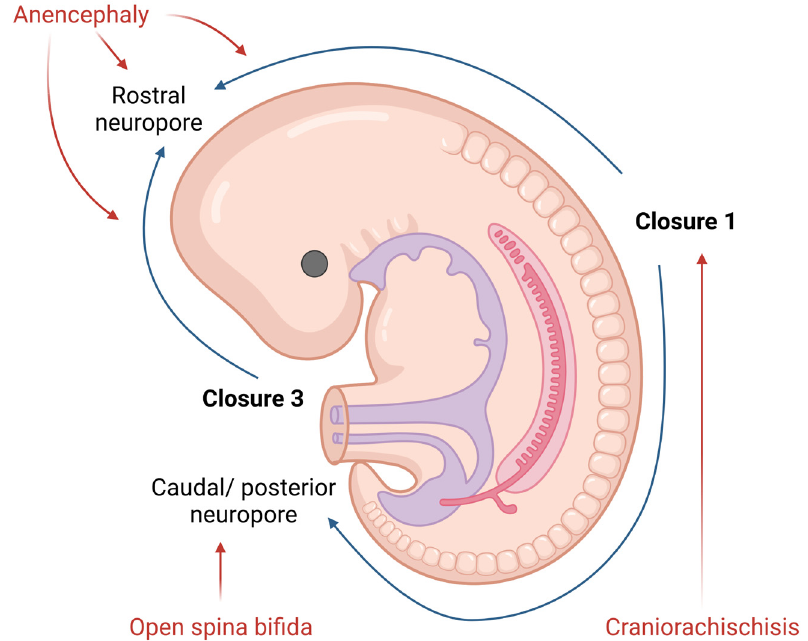
Figure 1. Diagram of neural tube closure and the origin of open NTDs in human embryos. Created with www.BioRender.com (accessed on 26 March 2022)